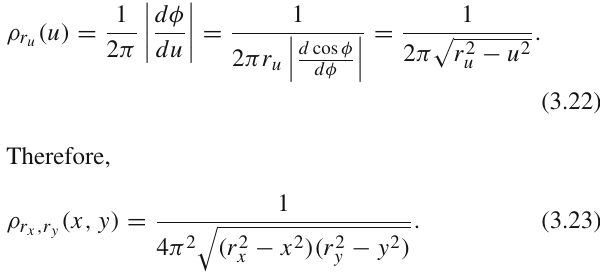
left by the black points for the artificial values Q x = 0 . 3, Q y = 1 / 3 and 5000 accelerator